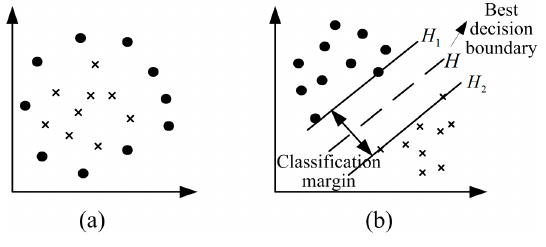
Figure 7. Principle of support vector machine (SVM): ( a ) original data; and ( b ) transformed data.